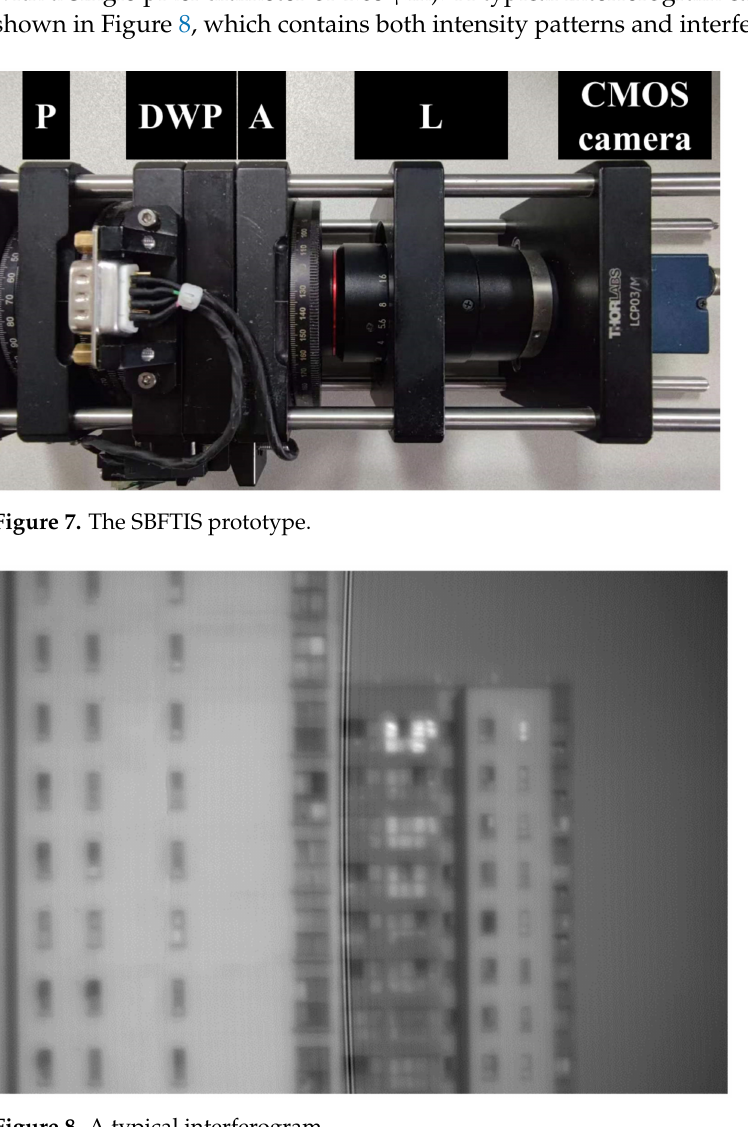
Figure 8. A typical